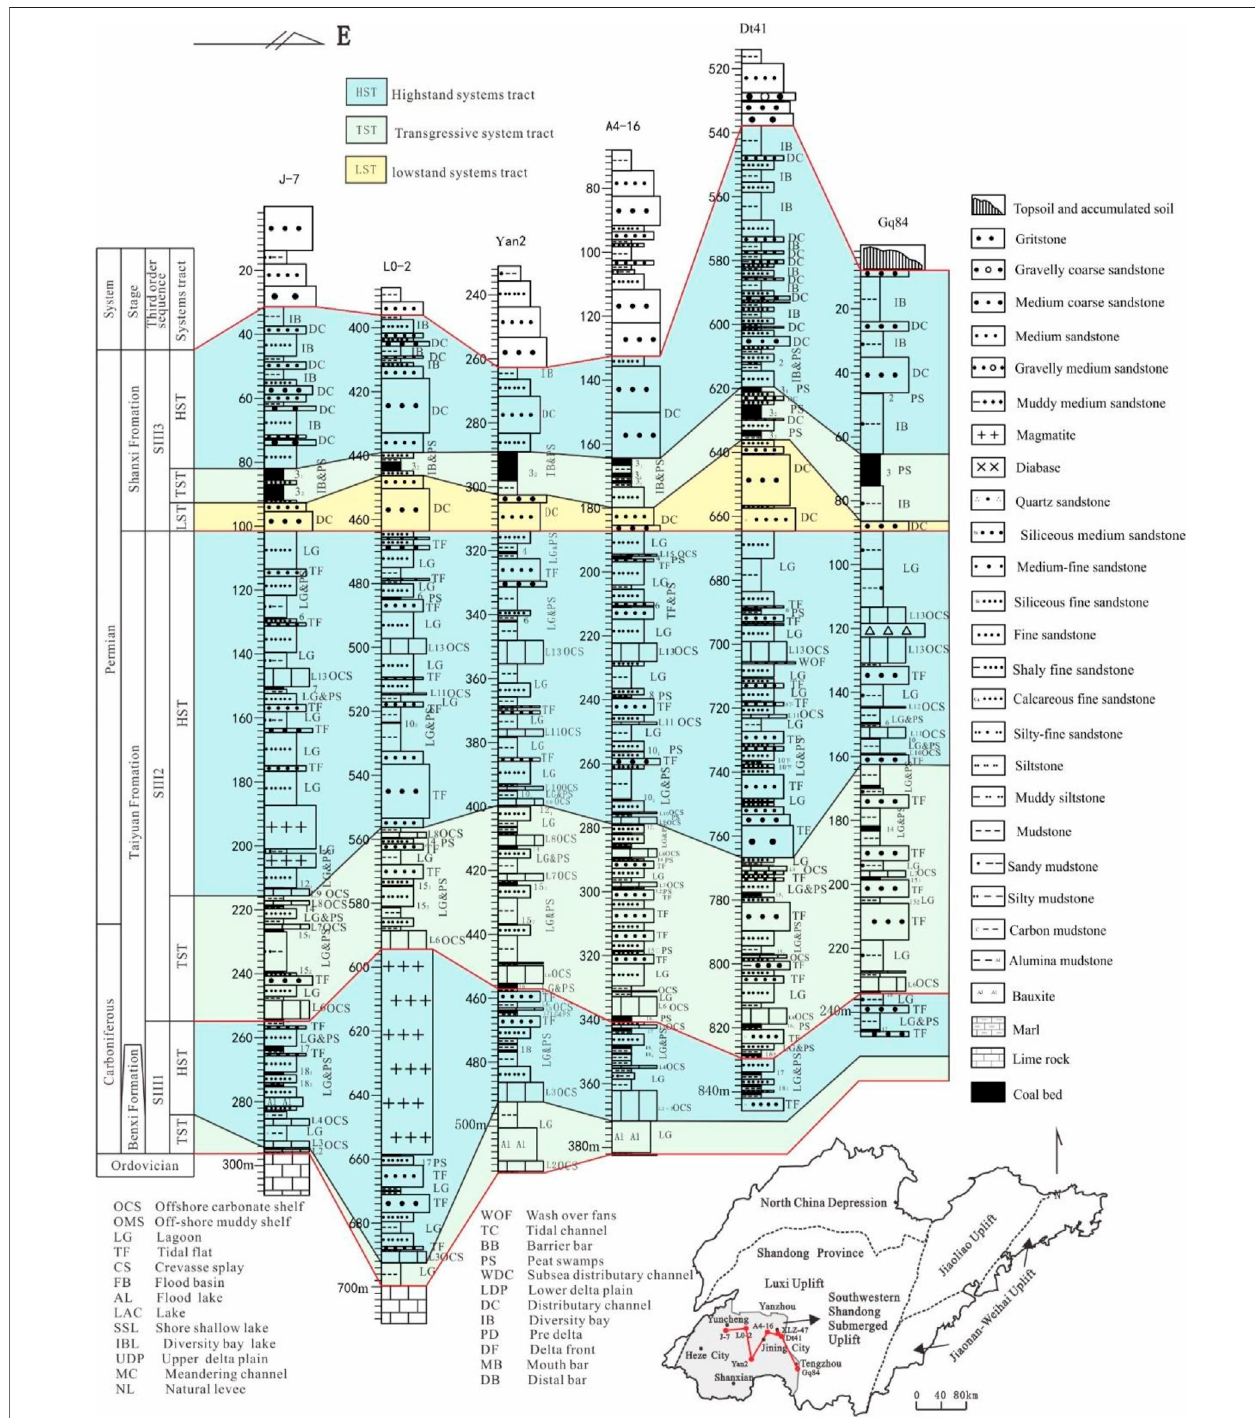
FIGURE 3 | Sedimentary facies and sequence stratigraphic correlation map (West to East).